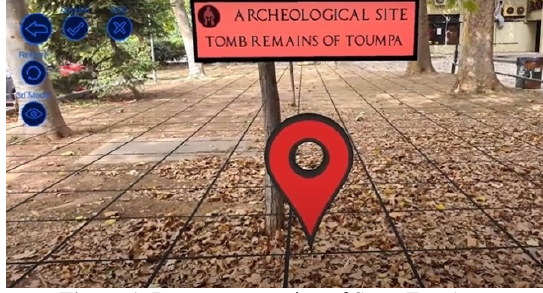
Figure 1 : Demo presentation of SmartEye